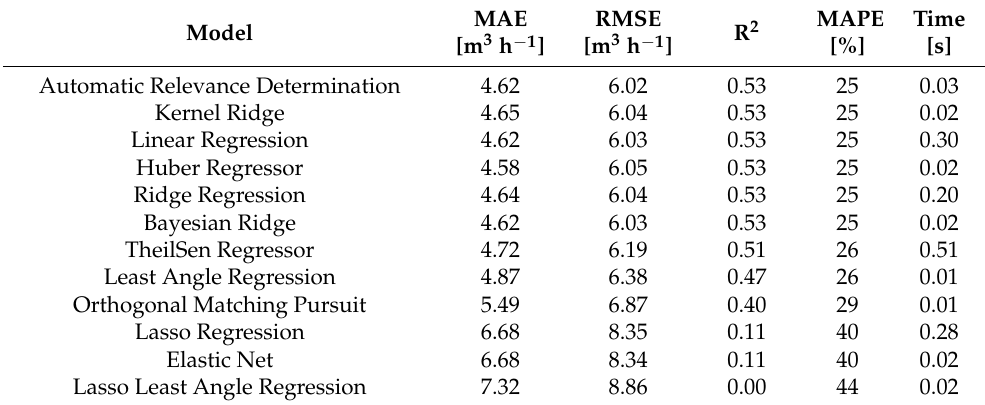
Table 6. Evaluation metric of models based on linear regression applied to the training set from mechanized timber harvesting operation.